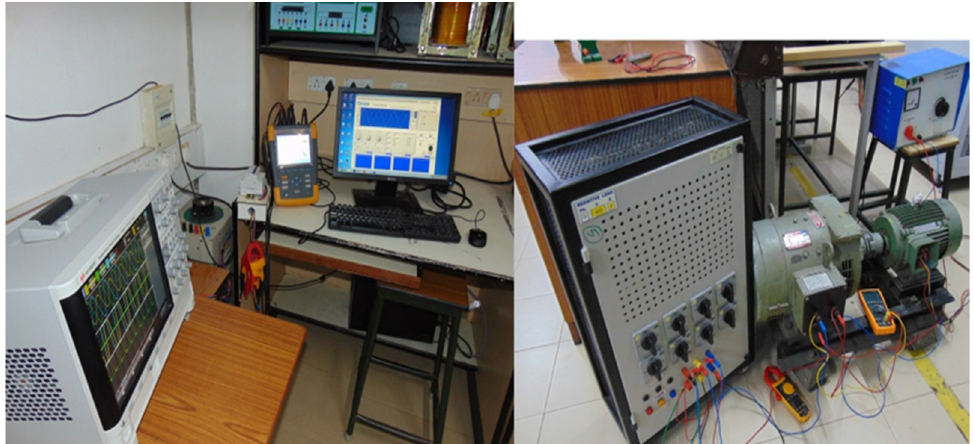
Figure 3. Experimental